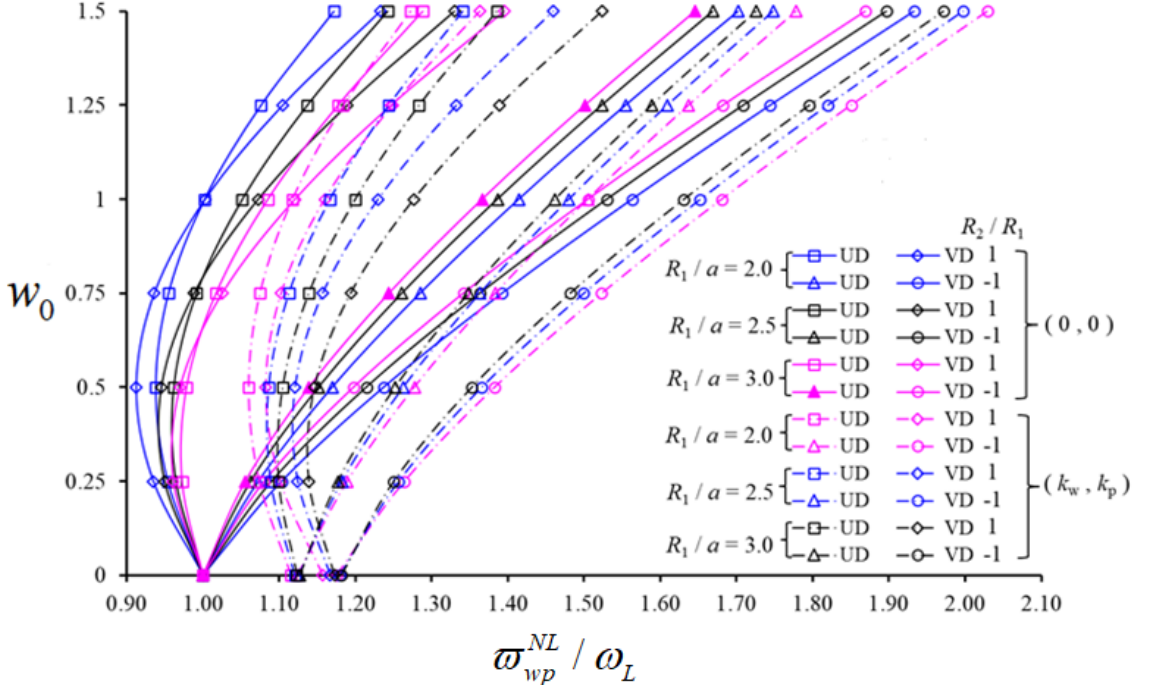
Figure 6. Variation in the NLFVF/LFVF ratio for shallow spherical and hypar shells with UD- and VD-patterned CNTs, in the presence/absence of a PF versus w 0 with different values of R 1 / a .